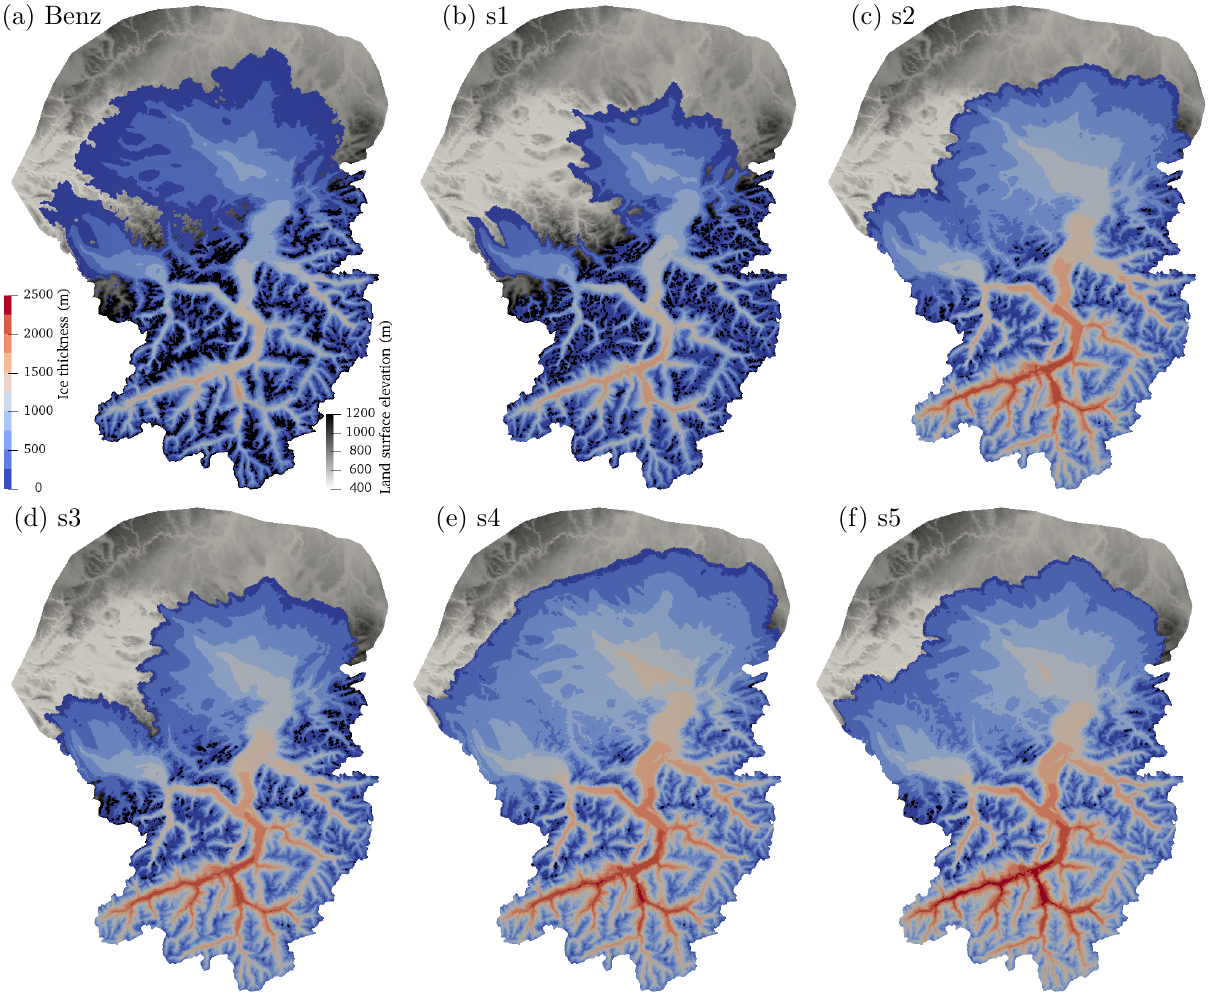
Figure 5. Ice thickness in meters for (a) Benz-Meier (2003) and (b–f) simulations